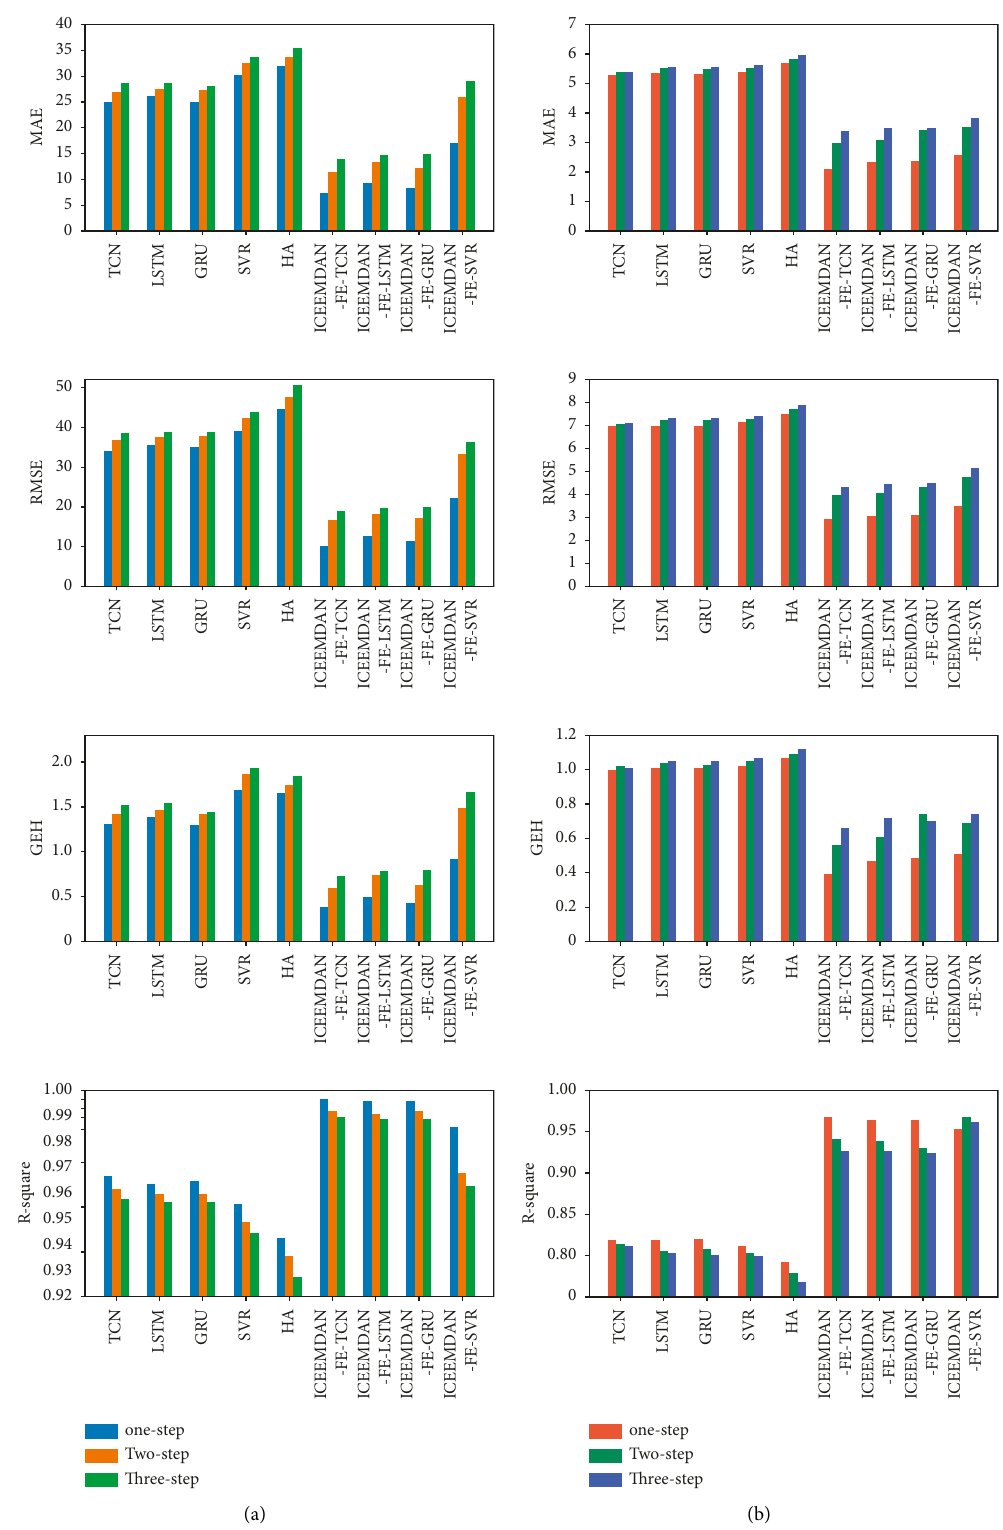
Figure 12: Prediction performance of different algorithms: (a) 717490 and (b)